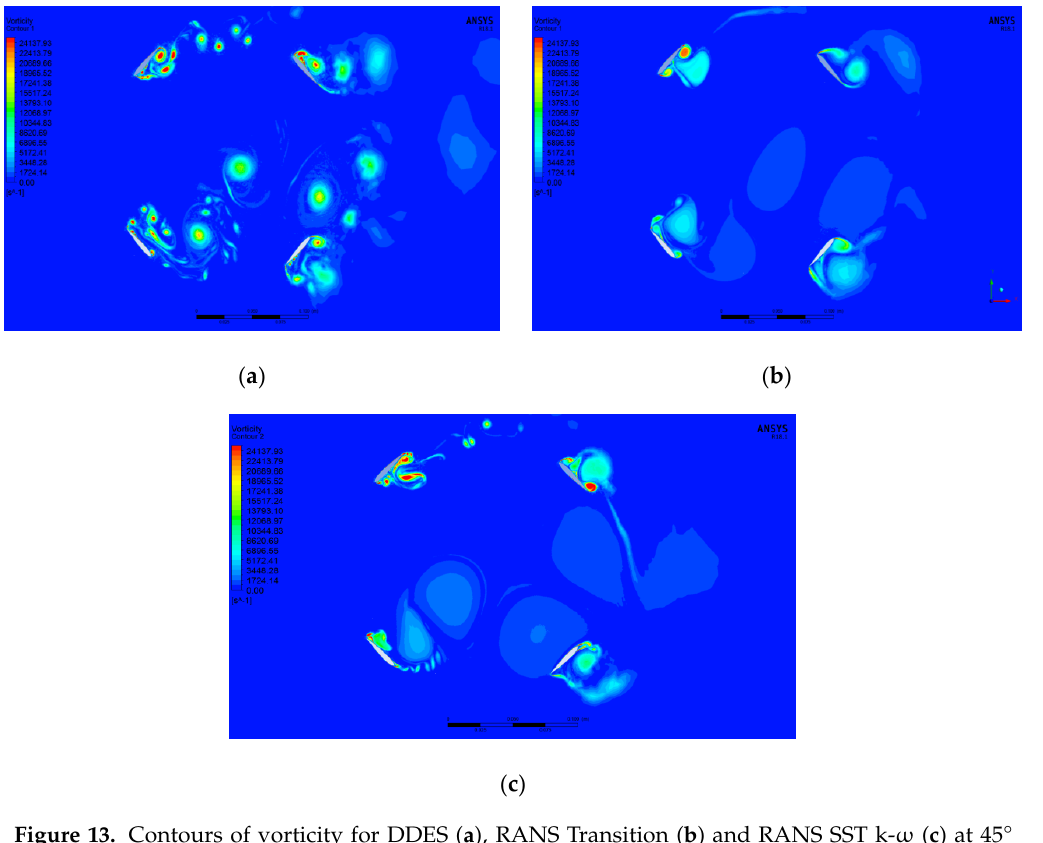
Figure 14. Velocity vectors ( a ) and contours of turbulence kinetic energy ( b ) for a blade at θ = 0° and λ max = 0.29.